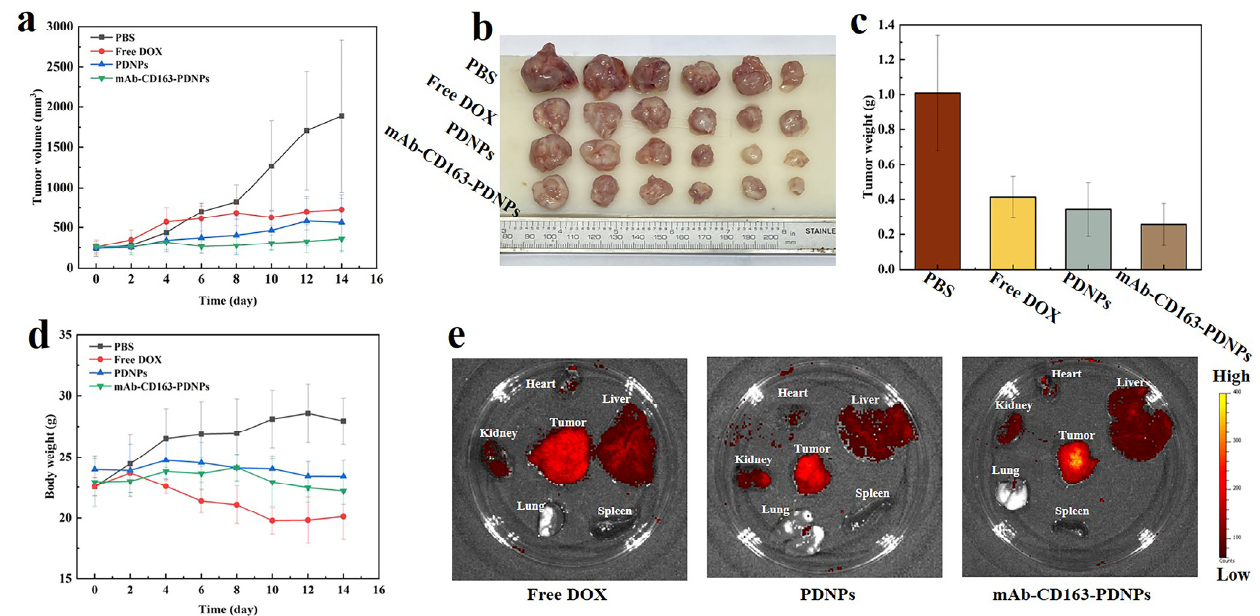
Figure 7. Anti-tumor ability in vivo. ( a ) Tumor volume of mice monitored during 14 days of treatment. ( b ) Representative picture of tumor after treatment on day 14. ( c ) Weight of tumor after treatment on day 14. ( d ) Changes in mouse body weight during treatment. ( e ) Drug distribution fluorescence images of mouse tumors and major organs.